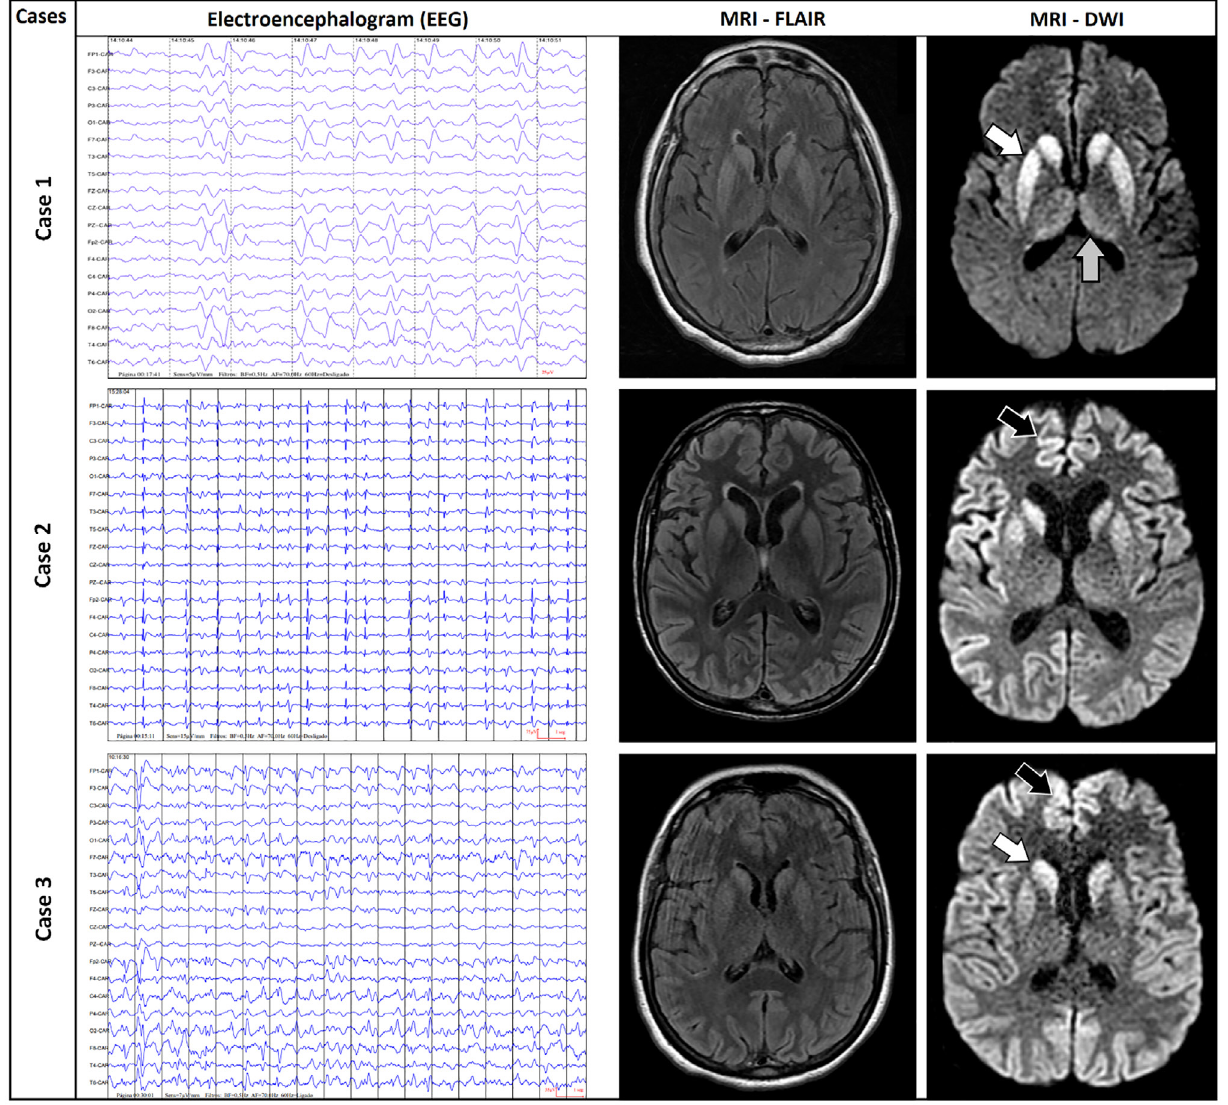
Figure 1. Axial diffusion-weighted and fluid-attenuated inversion recovery images showing bilateral involvement of the basal ganglia (Cases 1 and 3 – white arrows) and thalami (Case 1 – gray arrow). Axial diffusion-weighted shows more widespread signal hyperintensity in the cortical ribbon (Cases 2 and 3 – black arrows). Those findings are reported as usual Creutzfeldt-Jakob disease magnetic resonance imaging signs. Regarding the electroencephalograms, it is possible to note a diffuse repetitive triphasic wave discharges pattern with short periodicity in Case 1 and diffuse repetitive wave discharges pattern with short periodicity in Cases 2 and